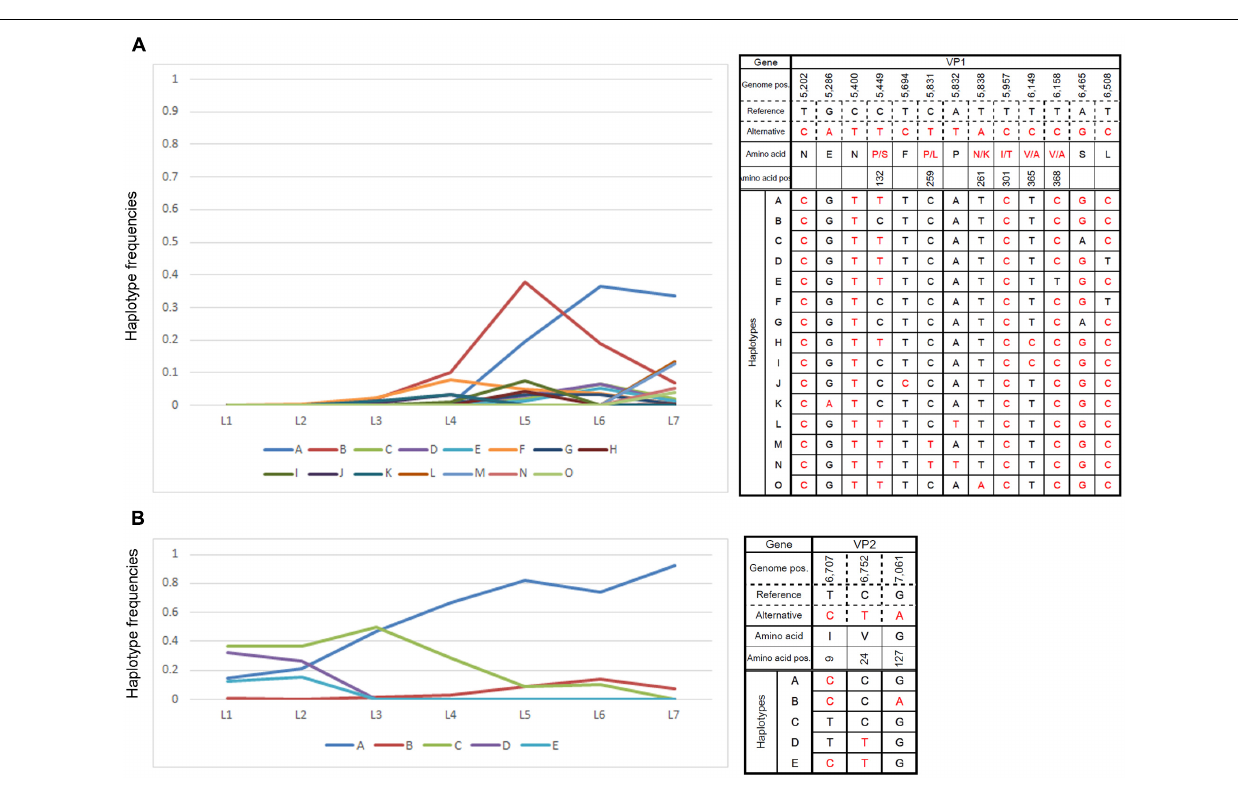
ORF1 PP3 and ORF23 PP2 ( Figure 5B , h ). The quantification of viral particles in the supernatant of cells transfected with PP3, PP3 + ORF23 PP2, and ORF1 PP2 + ORF23 PP2